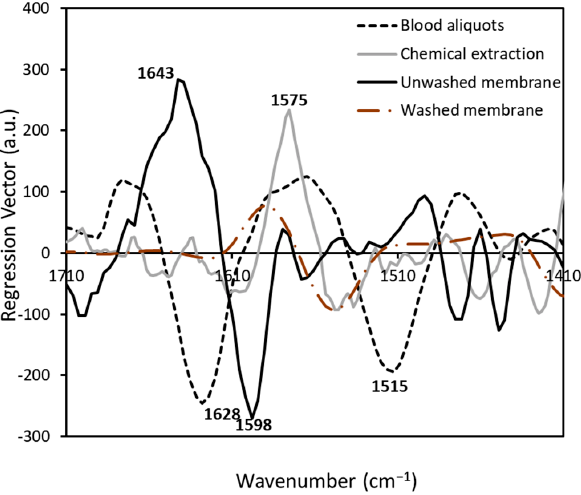
Figure 5. The regression vector plots of OPLS-DA regression models obtained from the spectral data of samples prepared by redissolving blood aliquots, chemical protein-precipitated extraction, washed membrane ultrafiltration extraction (LMF), and unwashed membrane ultrafiltration extraction (LMF with glycerol).